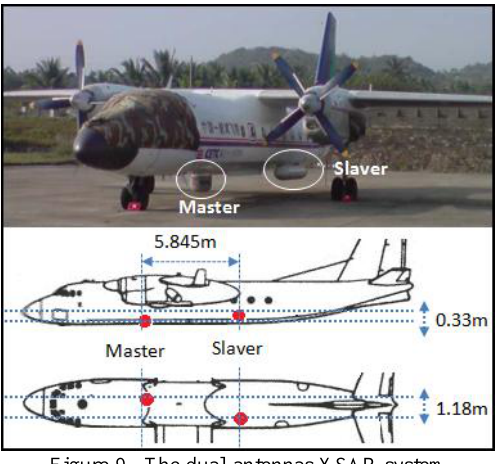
Figure 11. The classification result of Wishart-H-Alpha